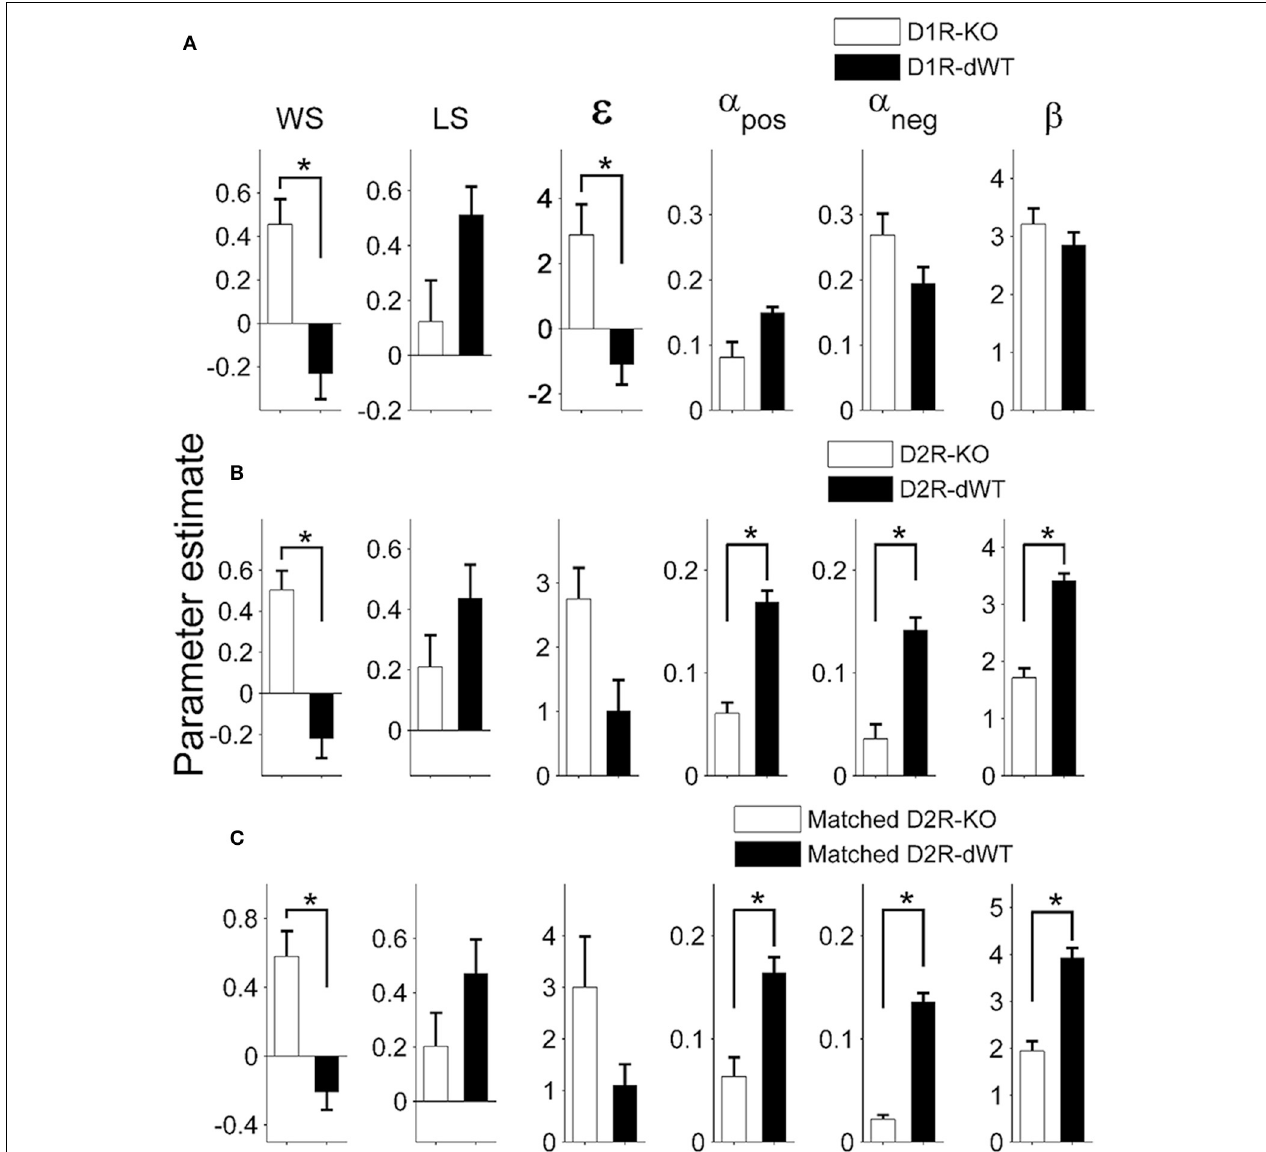
FIGURE 6 | Model parameters. Shown are coefficients for the explanatory variables of the full model applied to the behavioral data obtained during the TAB task (D1R, stages 1–3; D2R, stages 1–5; mean ± s.e.m. across animals). Asterisks, significant differences (Wilcoxon rank sum test, p < 0 . 05). (A,B)